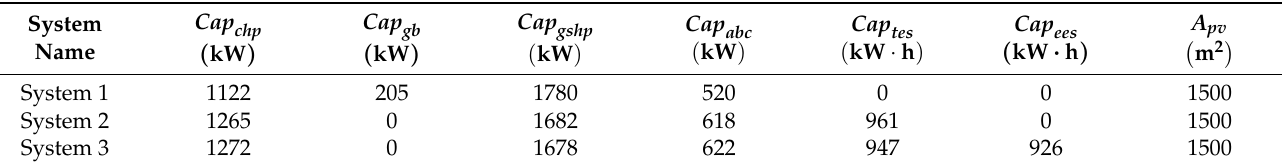
Table 8. System equipment